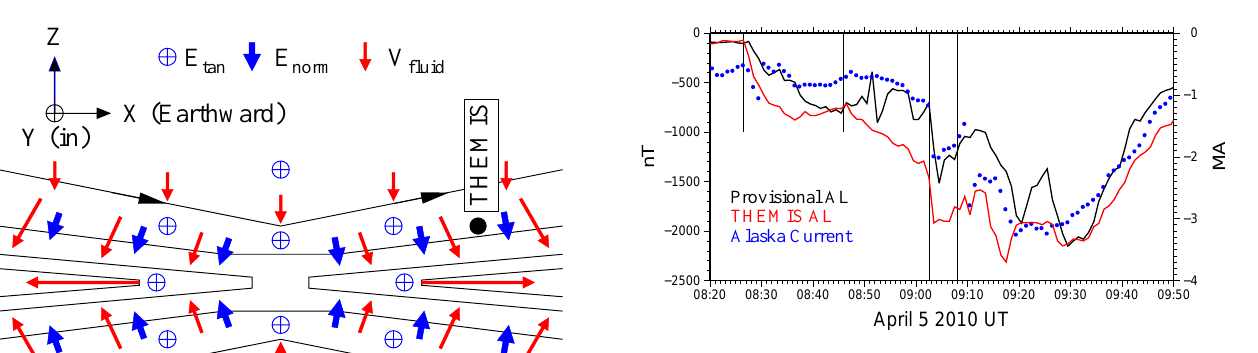
Fig. 4. Ground indices. Provisional and THEMIS AL indices (left scale), and the cross-meridian current in Alaska in MA (right scale). Vertical bars indicate the times of the shock arrival (leftmost) and the three substorm onsets described in the